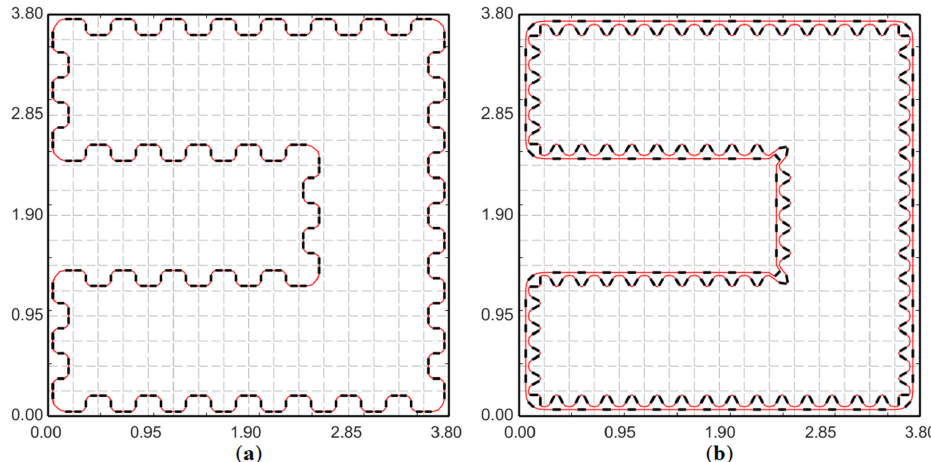
Figure 8. Fiber arrangements investigated: ( a ) Configuration-1 (with a wave-like fiber pattern, referred to as ‘Unitcell-1 ′ , repeated across multiple elements), and ( b ) Configuration-2 (with a strain rosette fiber pattern, referred to as ‘Unitcell-2 ′ , repeated across multiple elements).